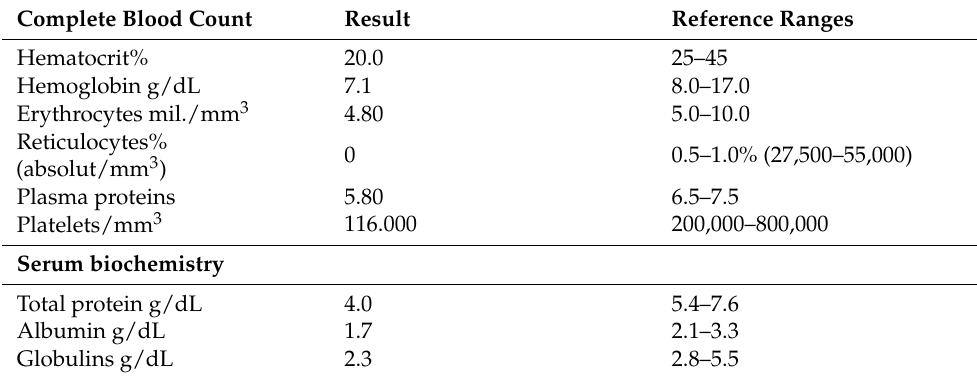
Table 1. Complete blood count and blood chemistry alterations of the